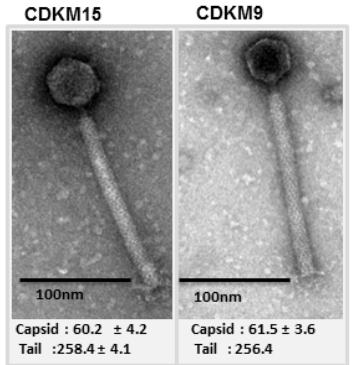
Figure 1. Transmission electron micrographs of phages CDKM15 and CDKM9. The sizes of the capsids and tails were measured for four particles and the mean values in nm with the standard deviations are reported below each phage. Viruses 2016 , 8 , 310